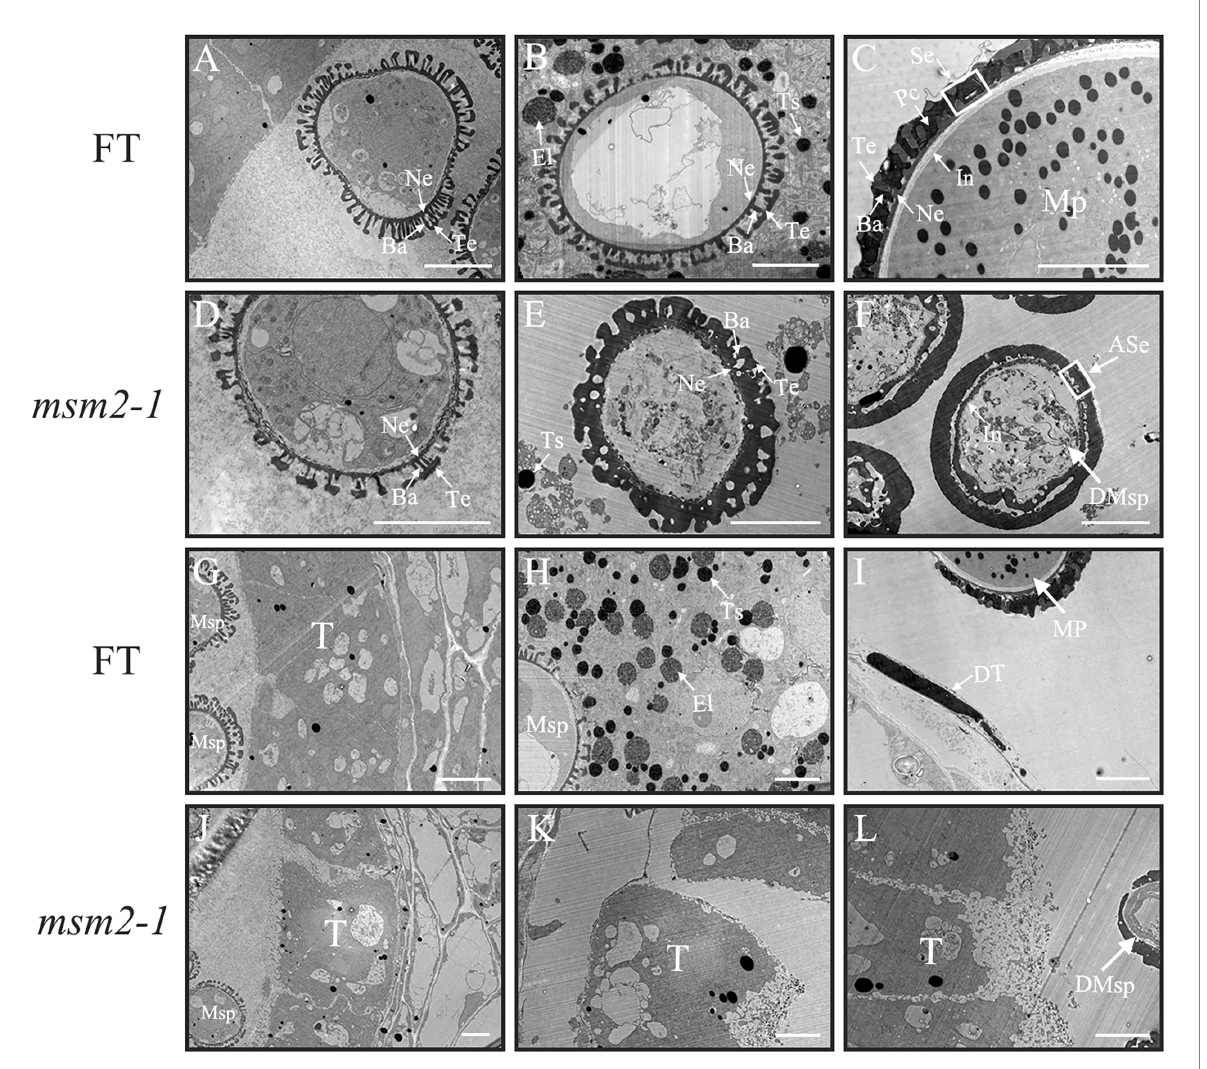
FIGURE 4 TEM analysis of pollen wall and tapetum development in the wild-type “FT” and msm2-1 mutant. The process of pollen exine development in wild-type “FT” and msm2-1 mutant at early (BUDS < 2.0 mm; A,D ), middle (2.0 mm < BUDS <3.0 mm; B,E ), late (BUDS > 3.0 mm; C,F ) stage. The process of tapetum development in wild-type “FT” and msm2-1 mutant at early (BUDS <2.0 mm; G,J ), middle (2.0 mm < BUDS <3.0 mm; H,K ), late (BUDS >3.0 mm; I,L ) stage; Scale bar, 5 μ m. T, Tapetal layer; DT, Degraded tapetum; Msp, Microspores; DMsp, Degenerated microspores; MP, Mature pollen grains, Ba, Bacula; Te, Tectum; Se, Sexine; In, Intine; ASe, Abnormal sexine; El, Elaioplast; Ts,